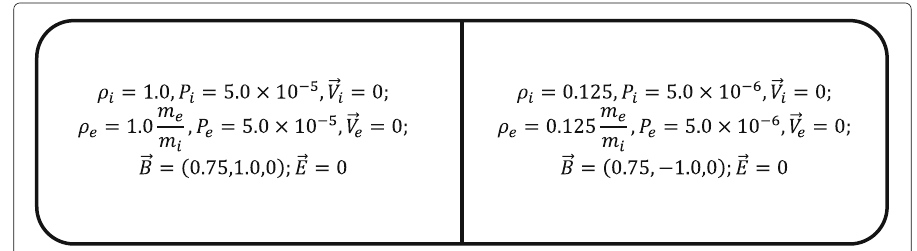
Fig. 7 Initial condition for the Brio-Wu shock tube problem